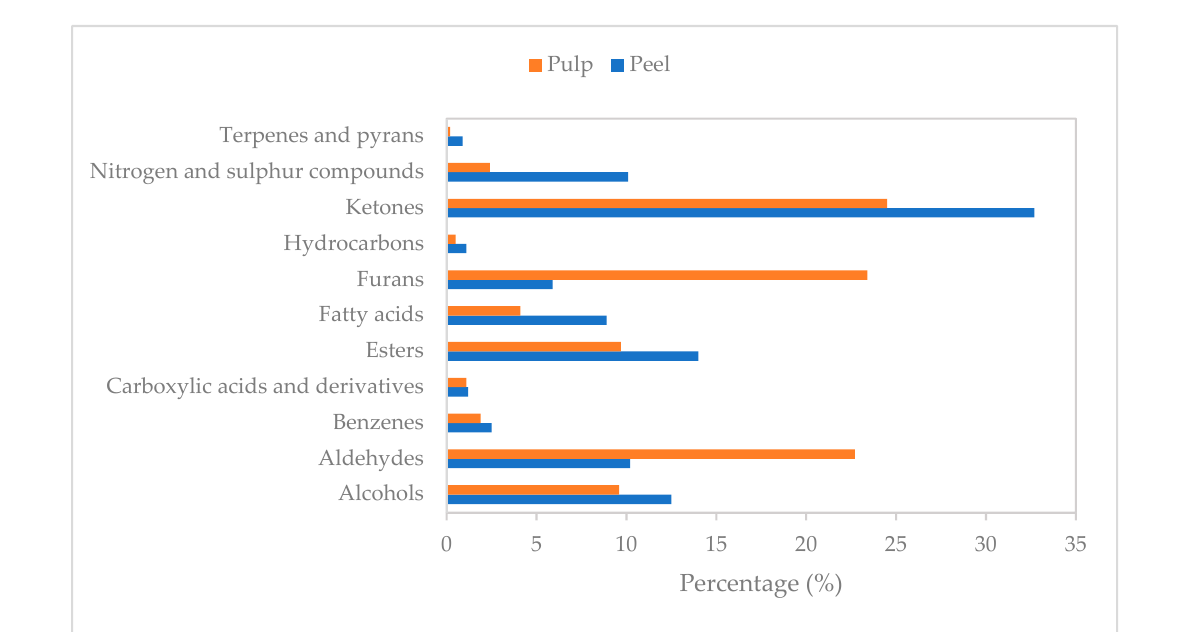
Figure 2. Relative percentage contents (%) of chemical groups identified in the pulp and peel of tamarillo.